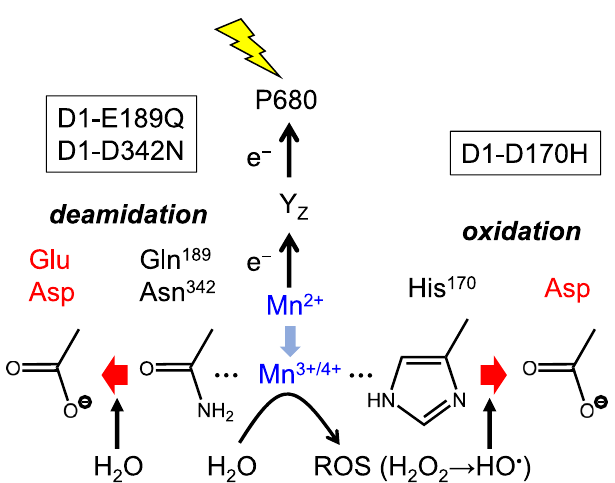
Fig. 4 Possible mechanisms of post-translational amino acid conversion to form carboxylate ligands. His in the D1-D170H mutant is oxidized to Asp by reactive oxygen species (ROS) such as a hydroxyl radical (HO • ) produced from H 2 O 2 , which is formed by partial oxidation of water at the Mn 3 + /Mn 4 + site. Gln and Asn in the D1-E189Q and D1-D342N mutants are converted to Glu and Asp, respectively, by